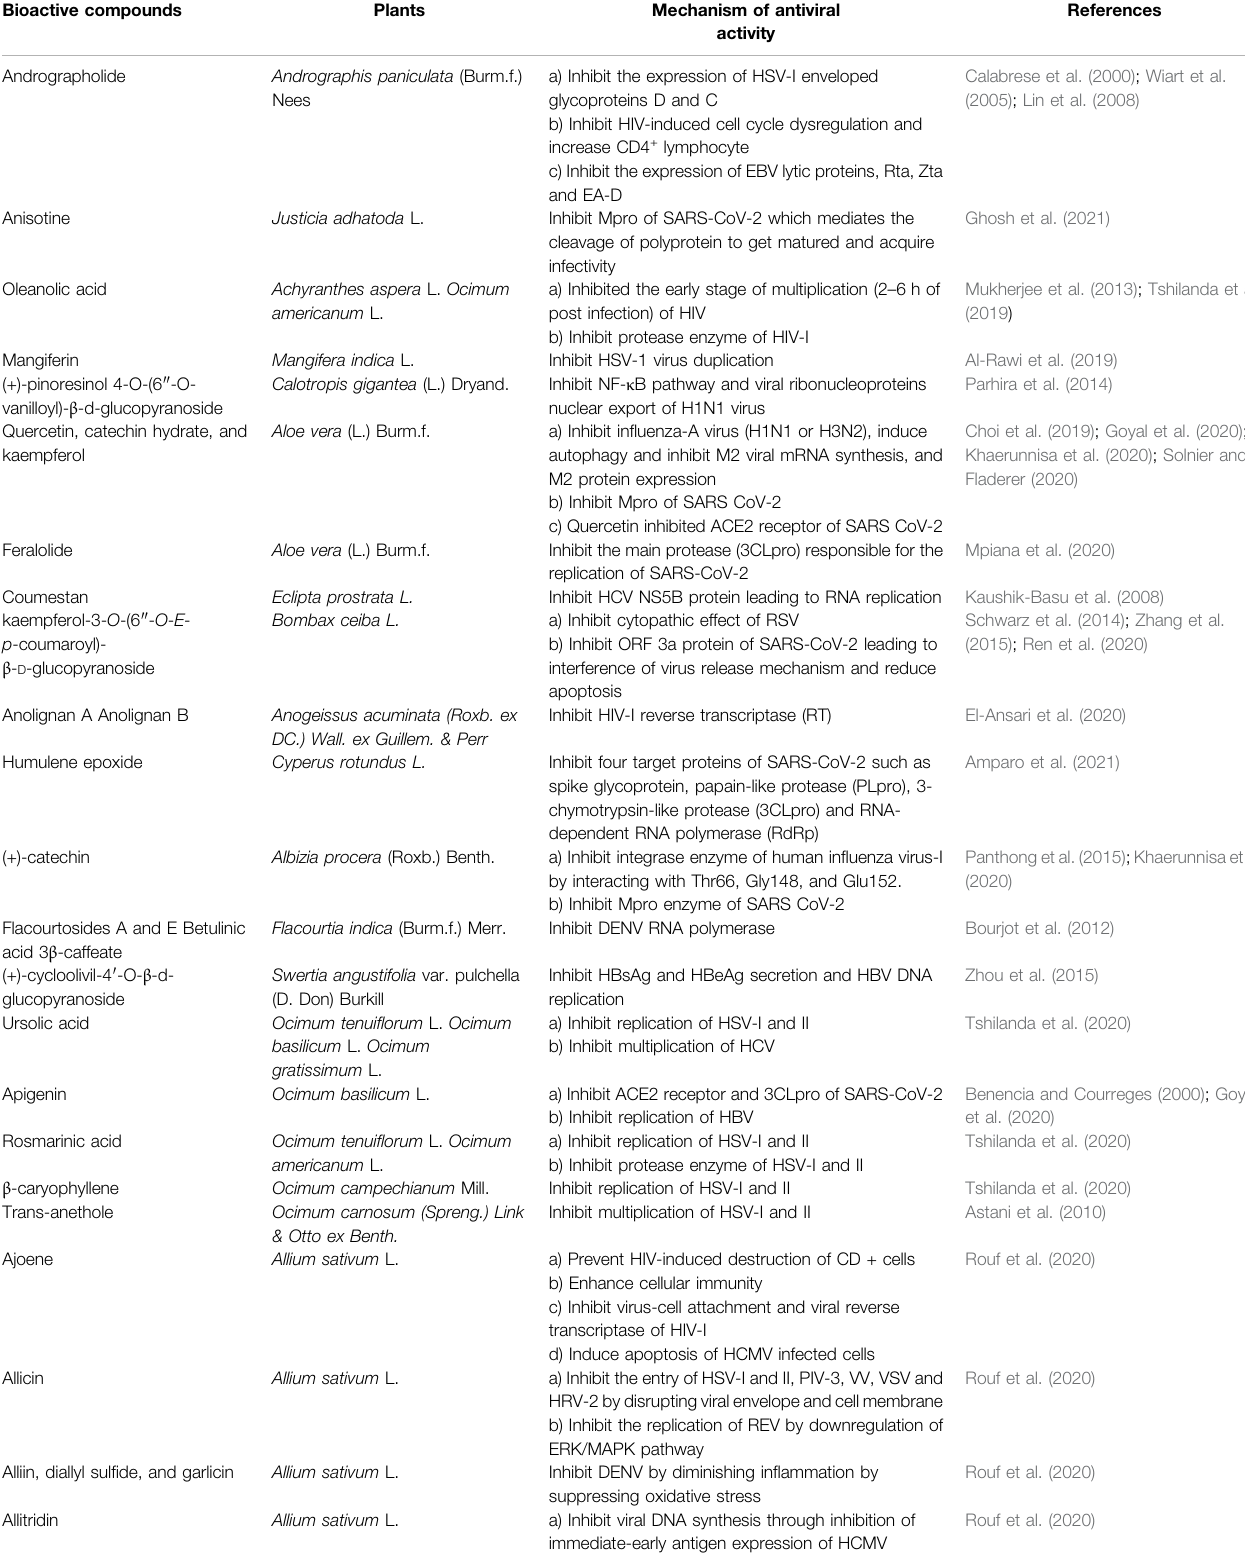
TABLE 3 | Bioactive compounds with antiviral mechanism isolated from medicinal